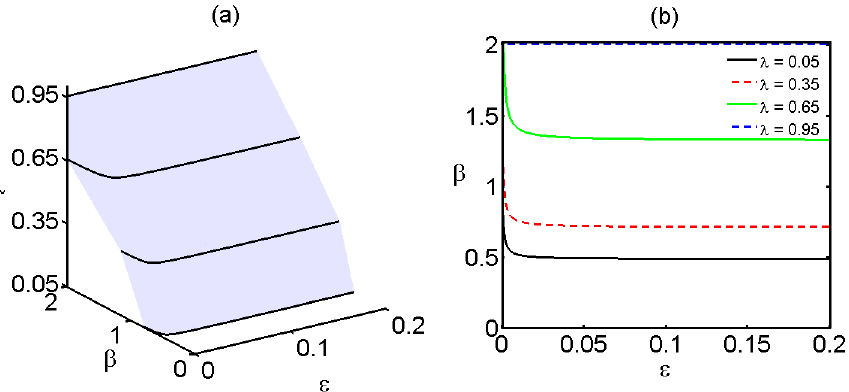
Figure 7. The stability region of the model: ( a ) 3D representation, ( b ) 2D representation. The portions below the curves represent the stable regions, while the portion above the curves represent the unstable regions of the model.